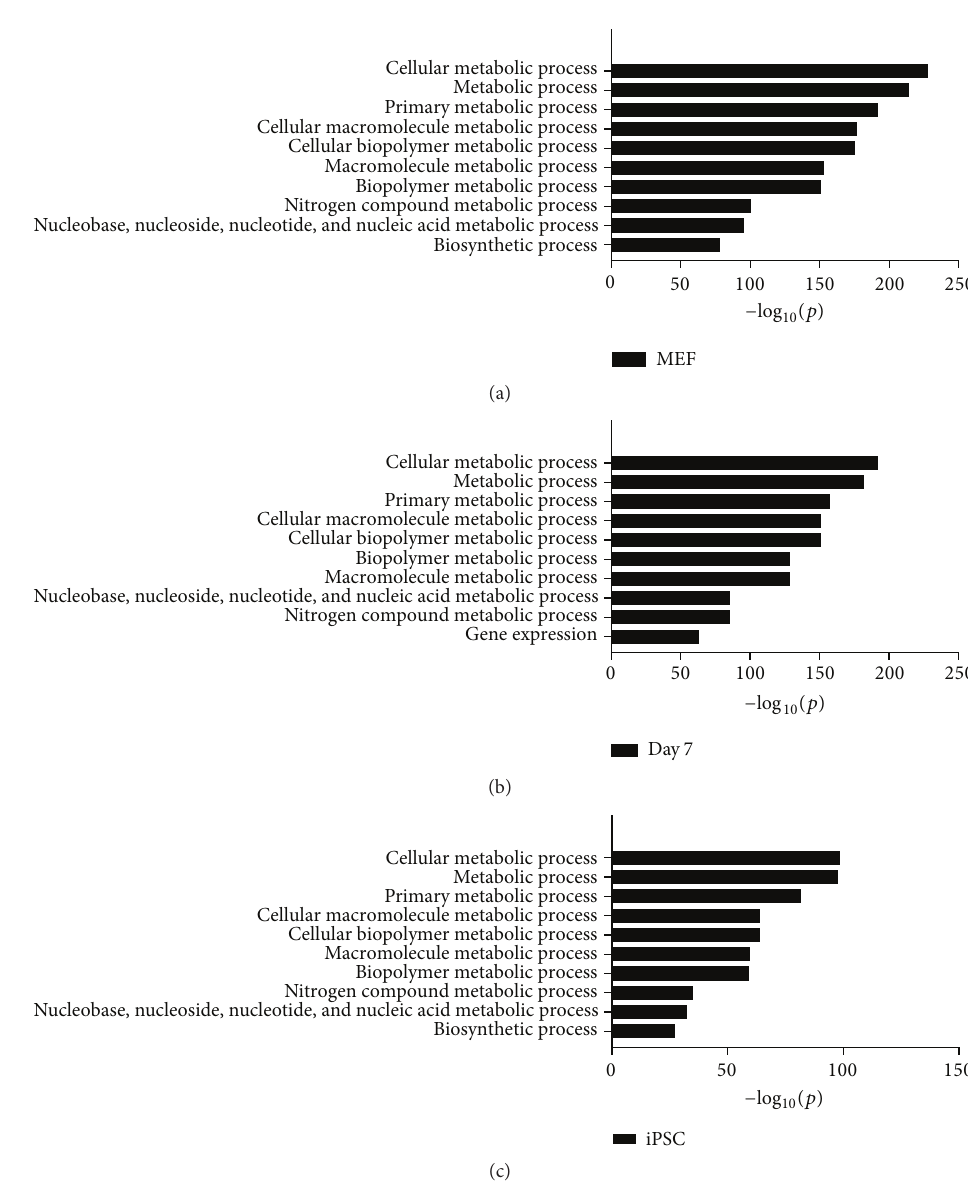
Figure 5: Top 10 biological processes undertaken by H2A.Z-associated genes in MEFs (a), Day 7 cells (b), and IPSCs (c). 𝑝 values for revaluation of GO categories among genes show evidence for enrichment of